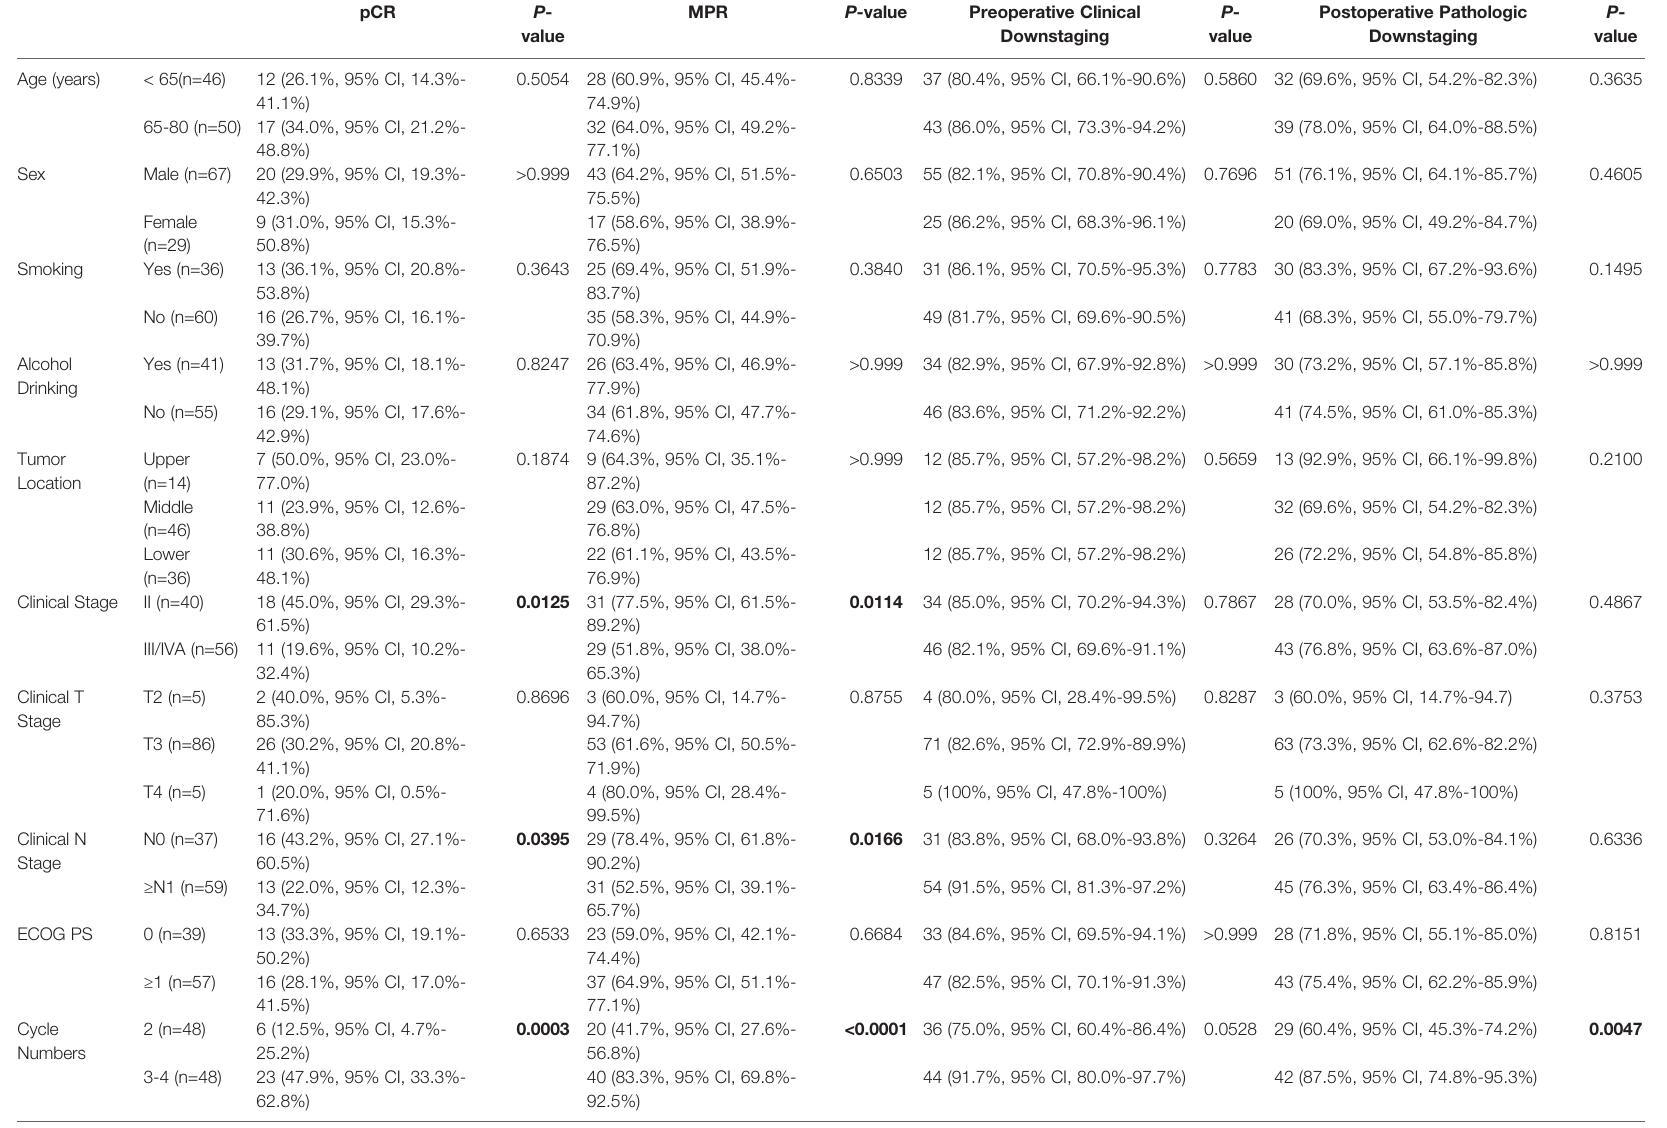
TABLE 3 | Subgroup